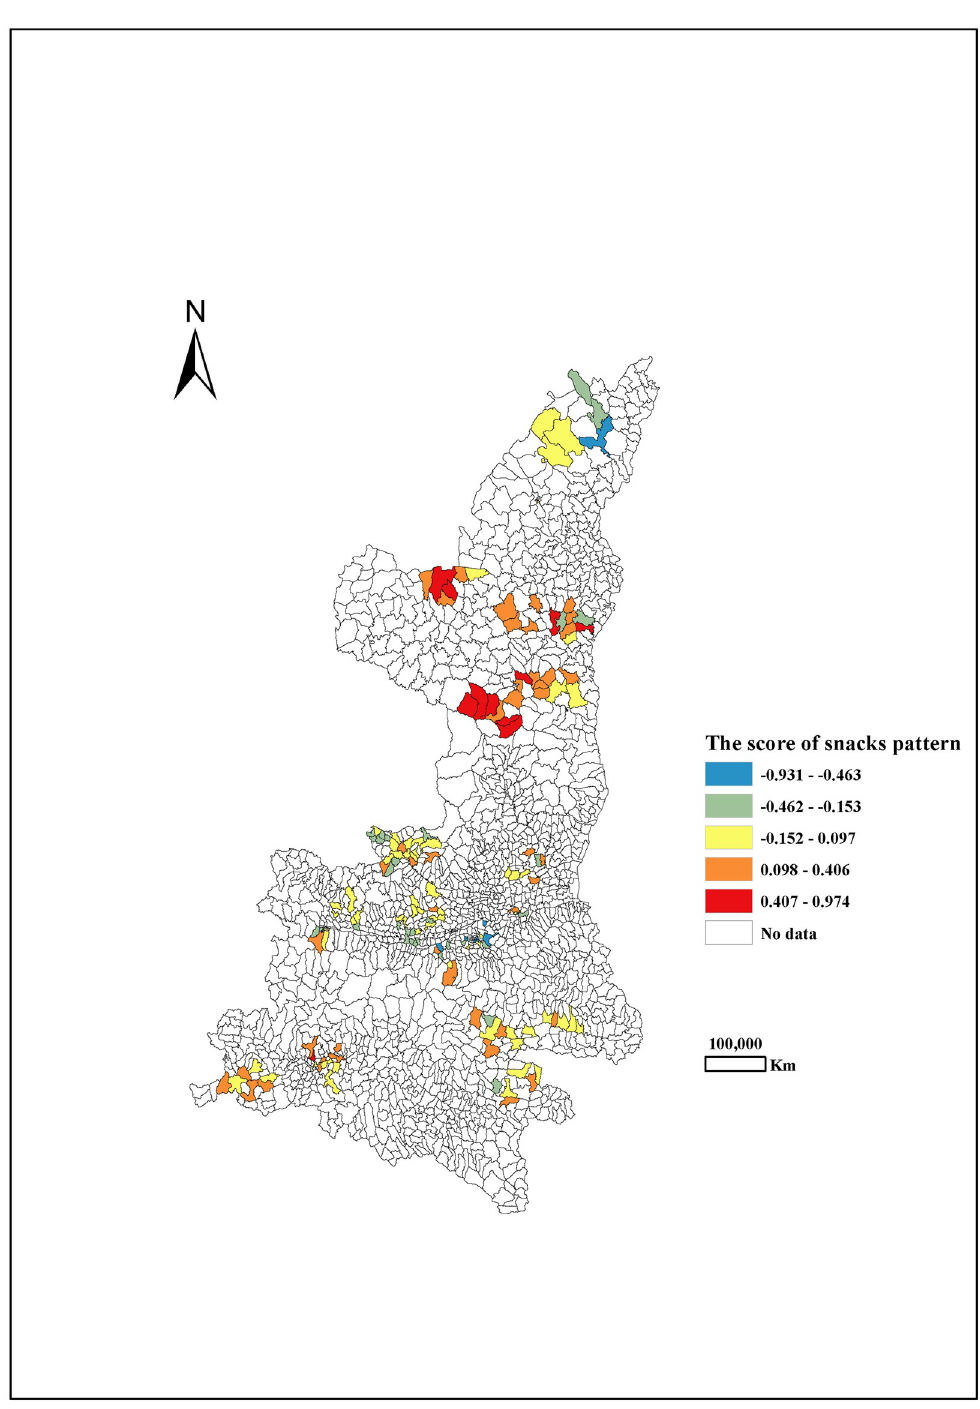
Fig 2. The score of snacks pattern among pregnant women by different areas in Shaanxi province, 2013.